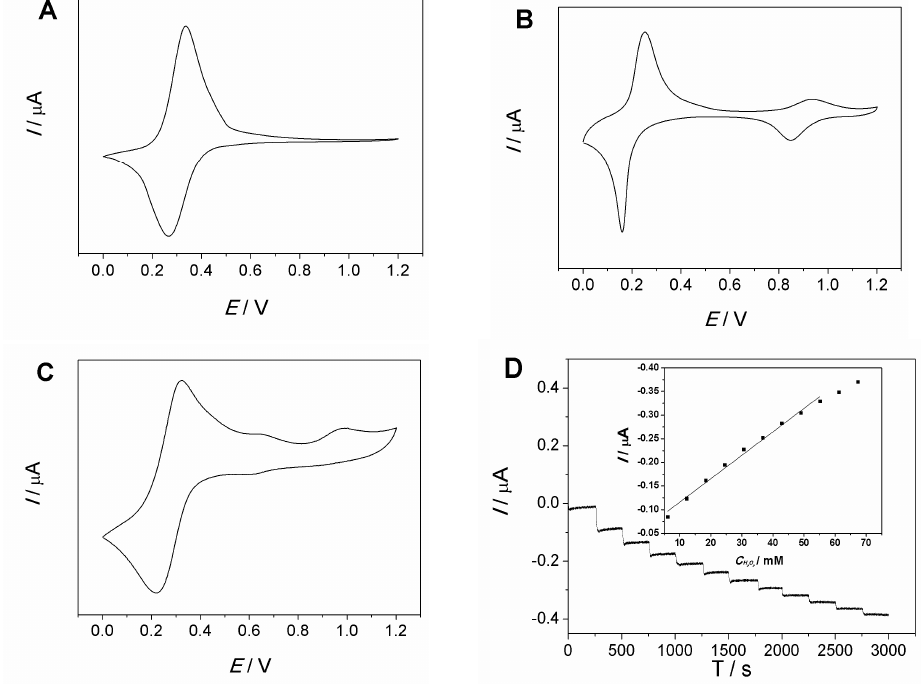
Figure 6. ( A ) CVs obtained on a freshly prepared MCF-IL-Fe(CN) 63 − /PVA electrode, ( B ) PB electrode and ( C ) acid-pretreated MCF-IL-Fe(CN) 63 − /PVA electrode in 0.1 M HCl + 0.1 M KCl solution. Potential range: 0.0 V~1.2 V; scan rate: 10 mV s − 1 ; ( D ) chronoamperometric curve for the acid-pretreated MCF-IL- Fe(CN) 63 − /PVA electrode for successive addition of 6.12 mM H 2 O 2 every 250 s in 0.1 M HCl + 0.1 M KCl solution at 0.2 V. Inset: calibration plot of MCF-IL-Fe(CN) 63 − /PVA electrode for H 2 O 2 detection.